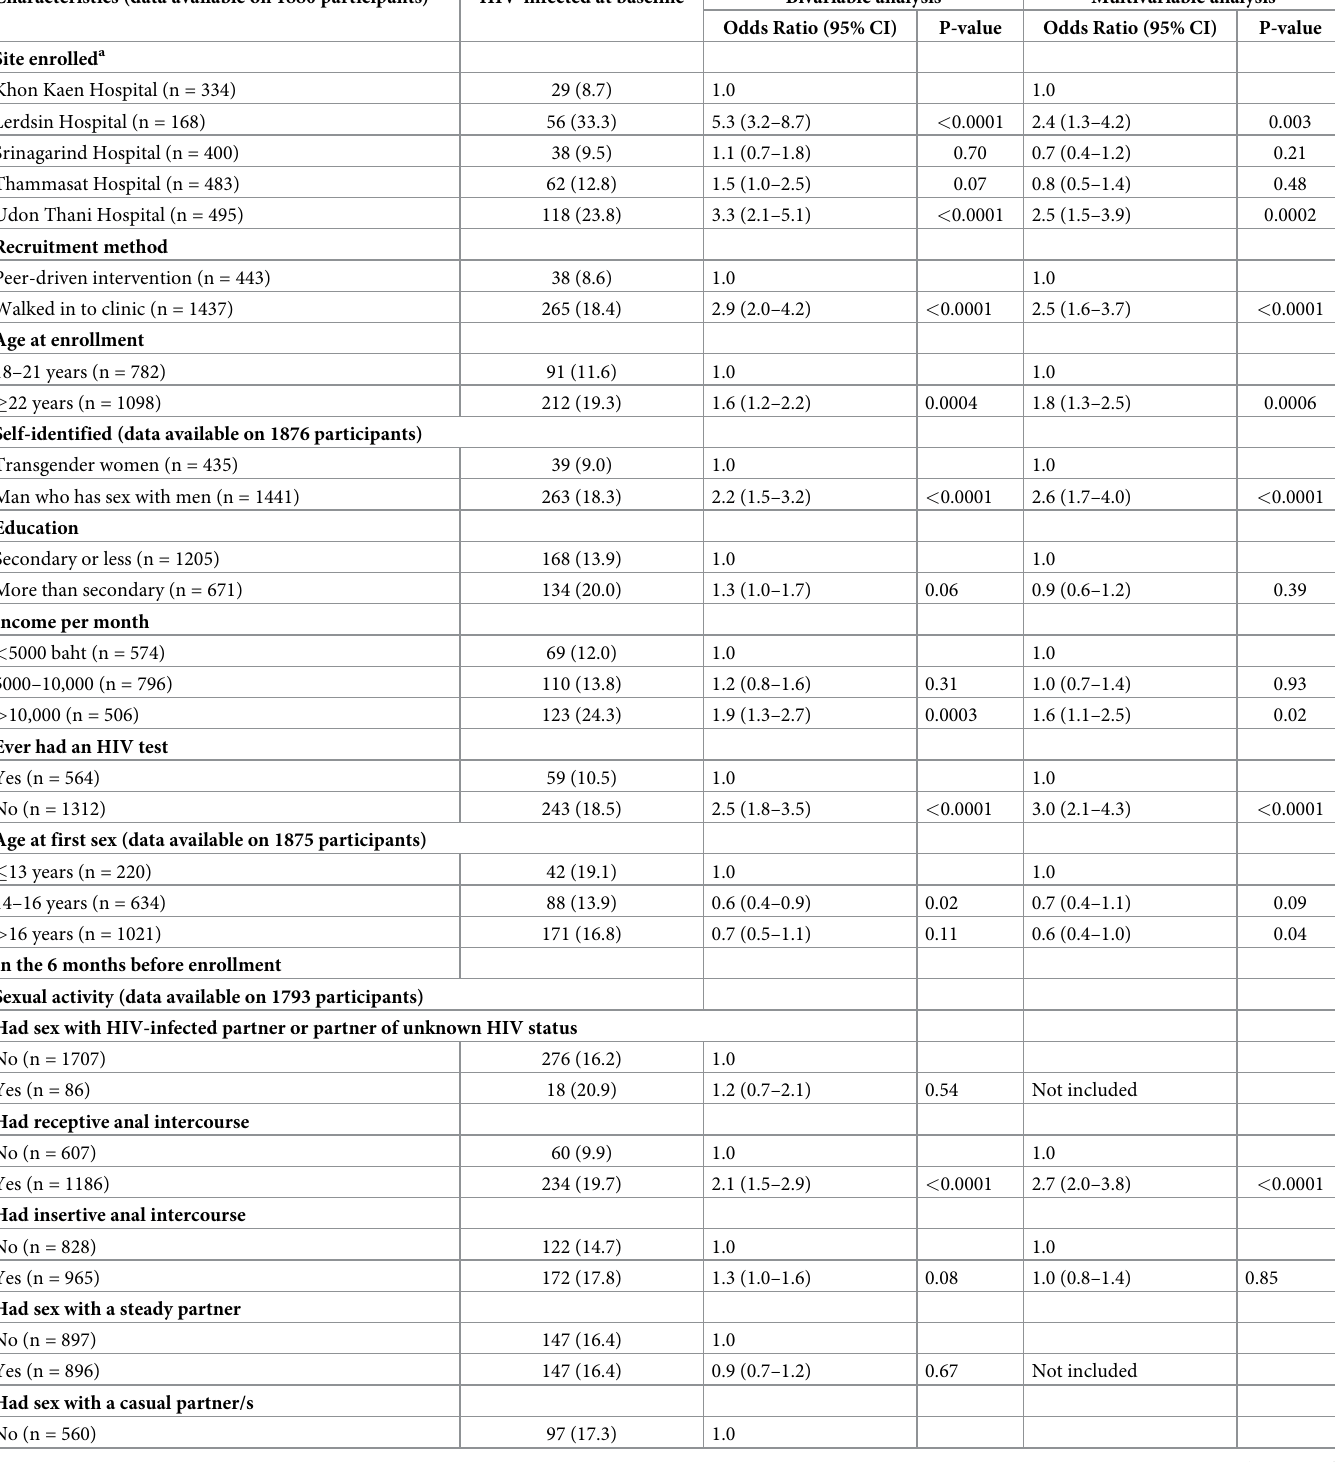
Table 3. Results of logistic regression analysis to evaluate characteristics of participants in the test, treat, and prevent HIV program associated with prevalent HIV infection, Thailand, 2015–2016. Characteristics (data available on 1880